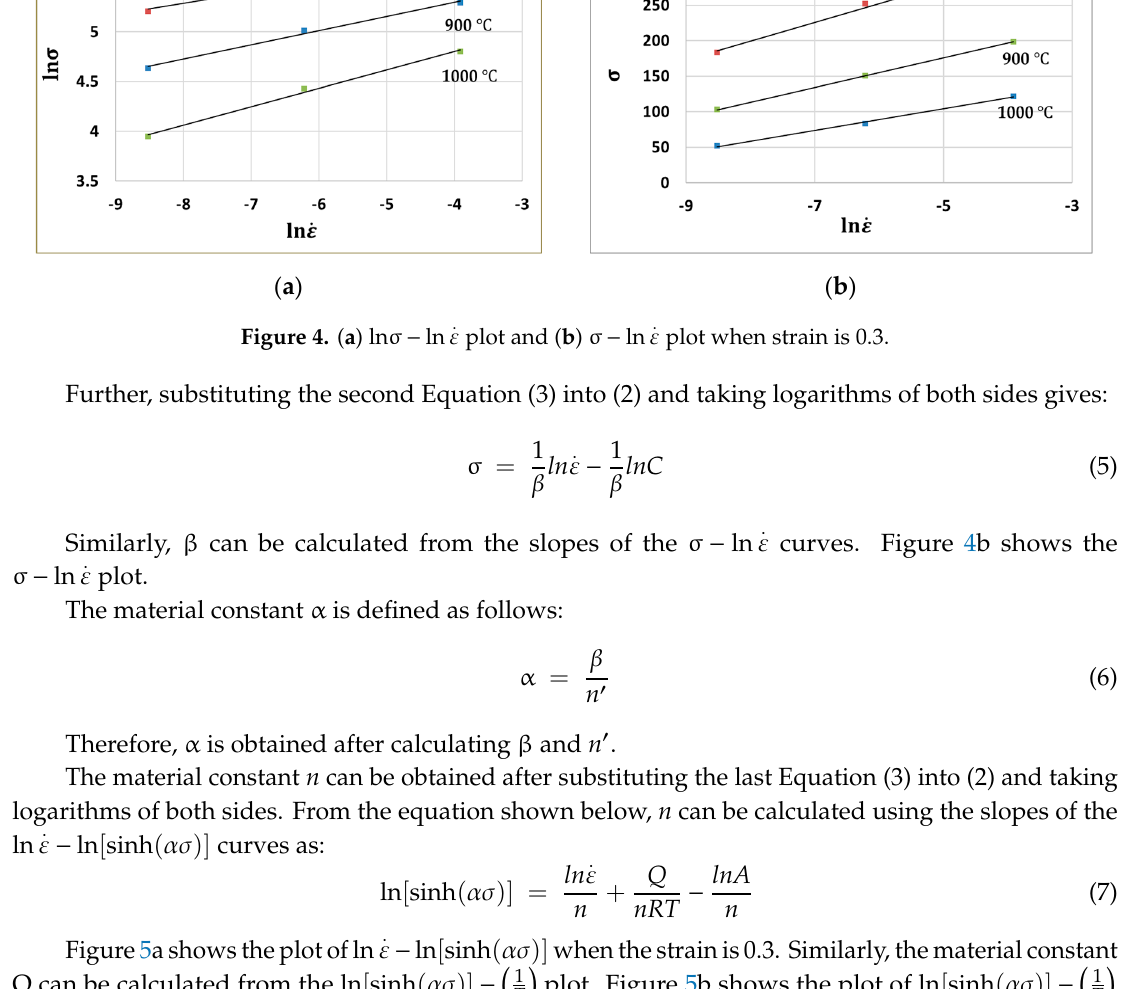
. ε plot and ( b ) σ − ln